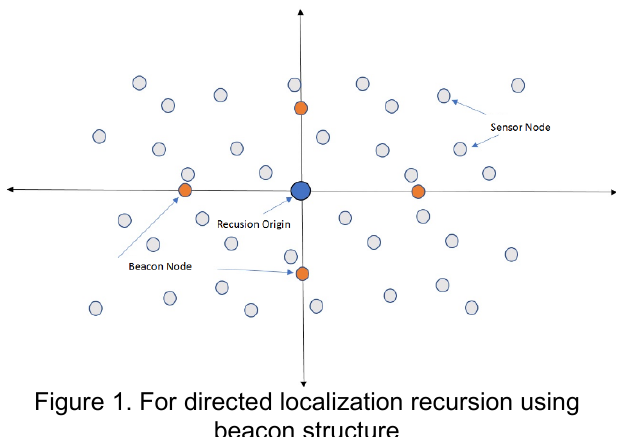
Figure 1. For directed localization recursion using beacon